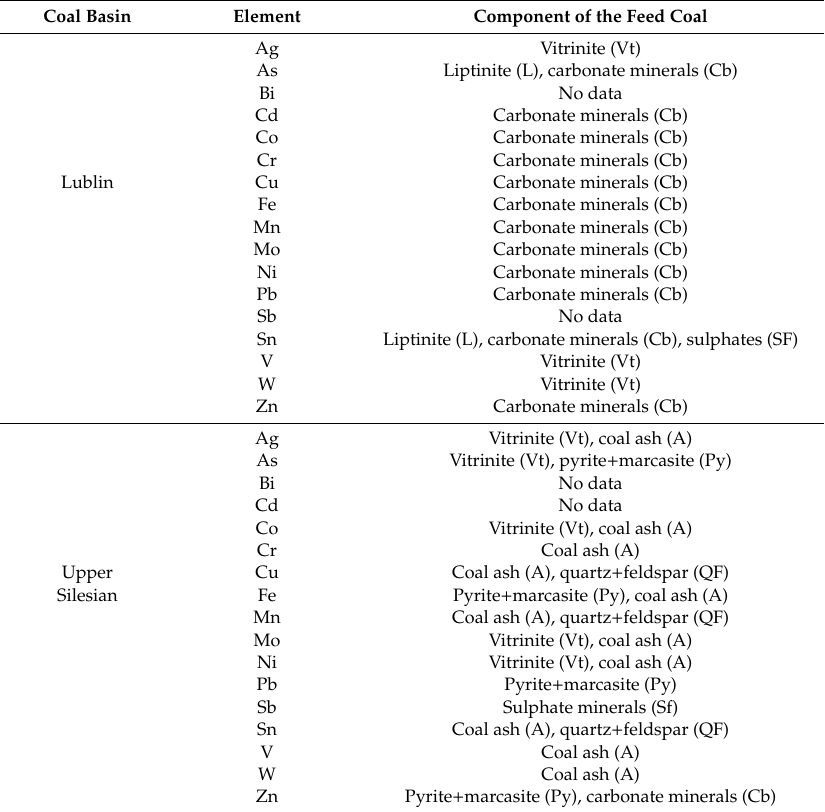
Table 4. Supposed modes of occurrence of elements in the feed